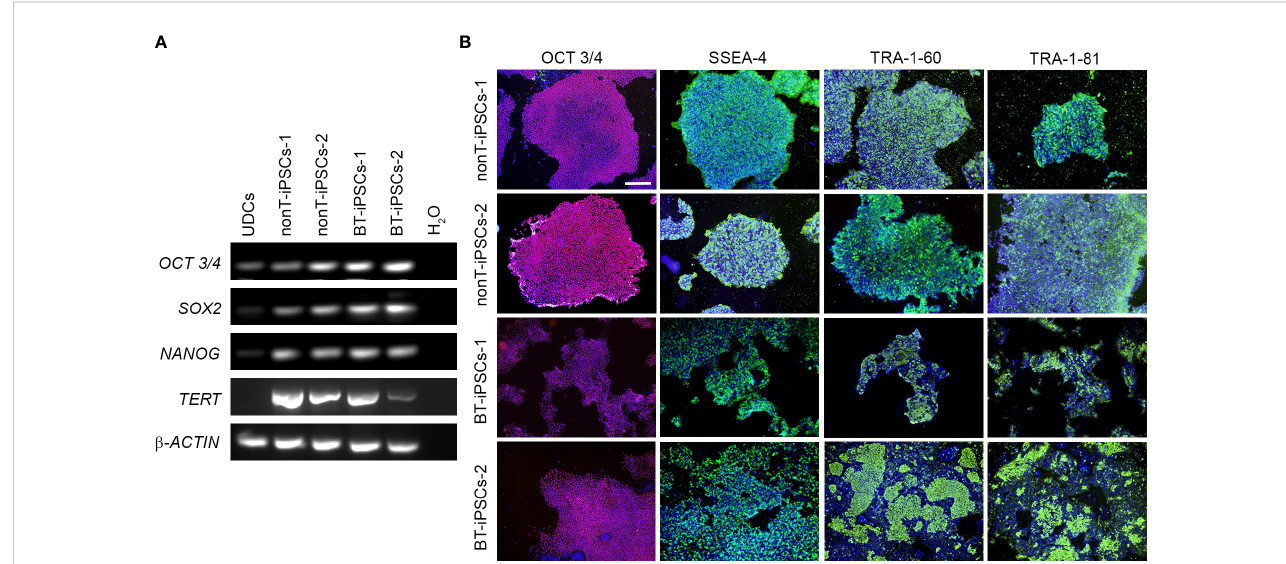
FIGURE 3 Analysis of the pluripotency markers in the generated iPSC lines. (A) RT-PCR analysis of the expression of pluripotency-associated genes. Note that all iPSC lines highly express OCT3/4, SOX2, NANOG and TERT , while UDCs do not. (B) Immuno fl uorescence staining showing the presence of pluripotency markers OCT3/4 (magenta), SSEA-4 (green), TRA-1-60 (green) and TRA-1-81 (green) in the iPSCs. Nuclei were counterstained with Hoechst 33342 (blue). Scale bar 100